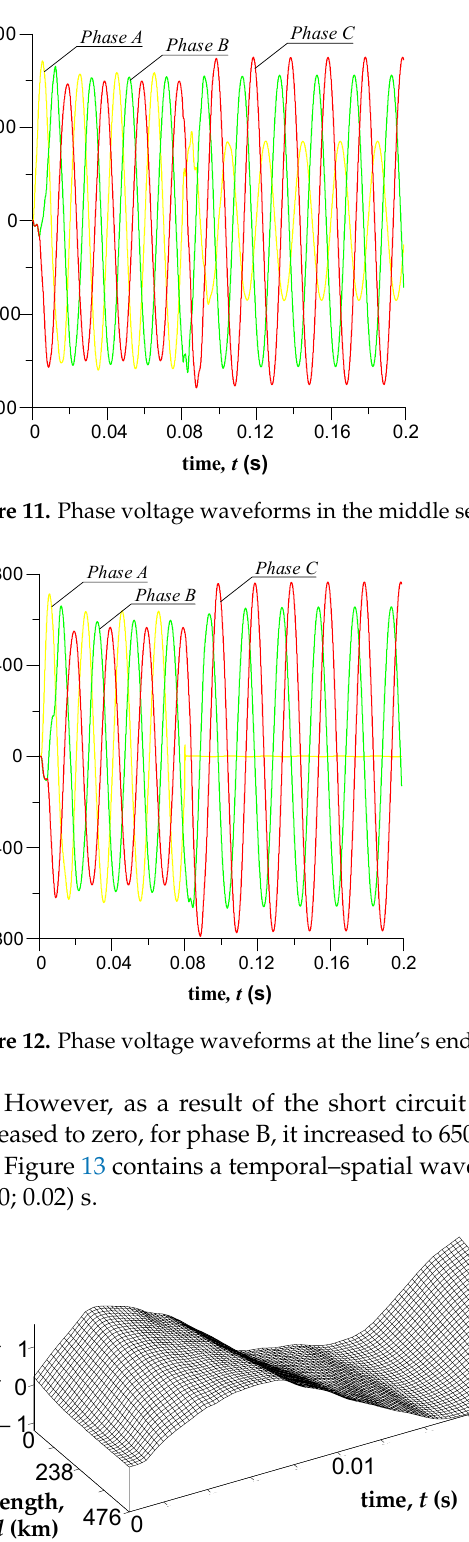
Figure 11. Phase voltage waveforms in the middle section of the line.